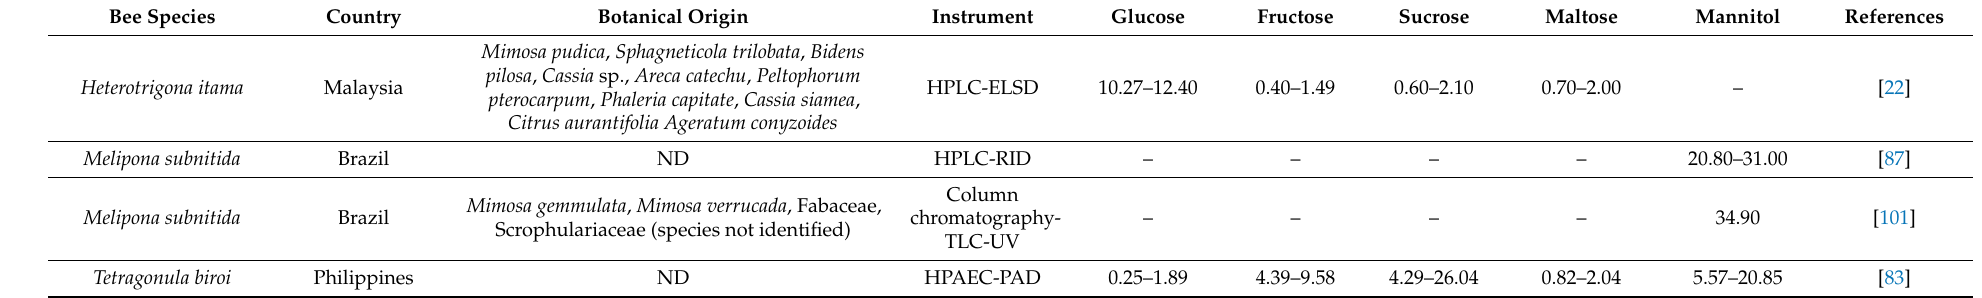
Table 3. Sugar content in stingless bee bee bread (g/100 g).